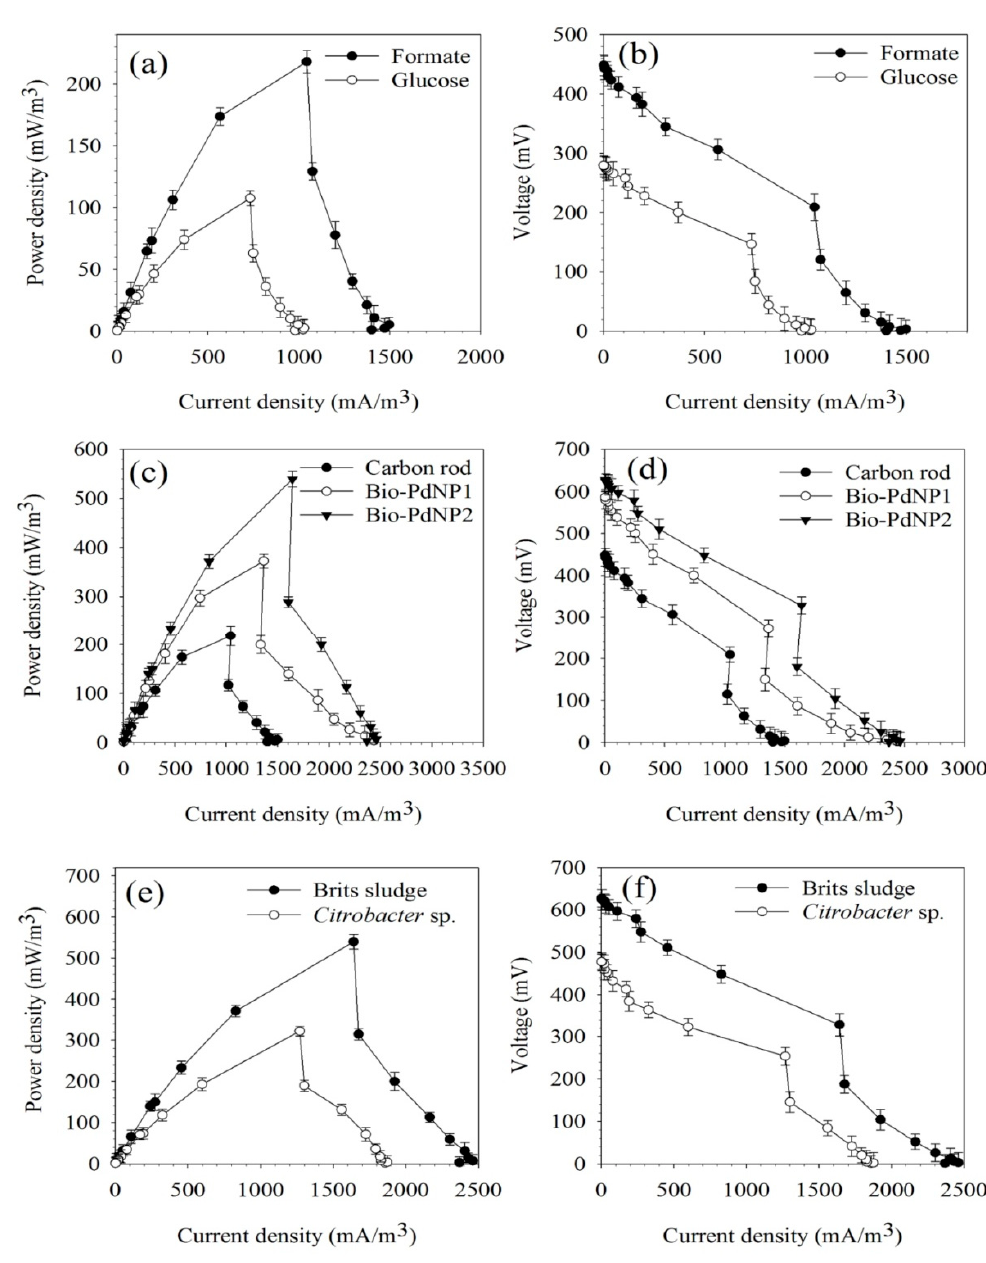
Figure 10. ( a ) Power output ( b ) and polarization curve of Microbial Fuel Cell (MFC) at different substrates (formate and glucose) using Brits sludge; ( c ) power output, ( d ) and polarization curve of MFC with carbon rod anode as a supporting material modified with Bio-PdNP1 (2 mg Bio-PdNP/cm 2 ) and Bio-PdNP2 (4 mg Bio-PdNP/cm 2 ); ( e ) power output ( f ) and polarization curve of MFC under Brits sludge and pure isolate ( Citrobacter sp.) using anode modified with Bio-PdNPs (4 mg Bio-PdNP/cm 2 ).